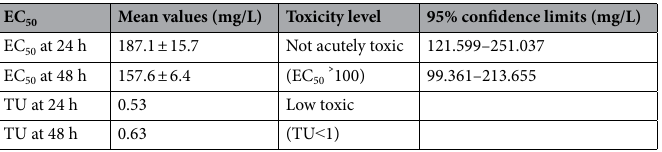
Table 2. EC 50 and TU of PANI/Ag (AMPSA)/GO QDs NC after 24 and 48 h of exposure to Ostracods.